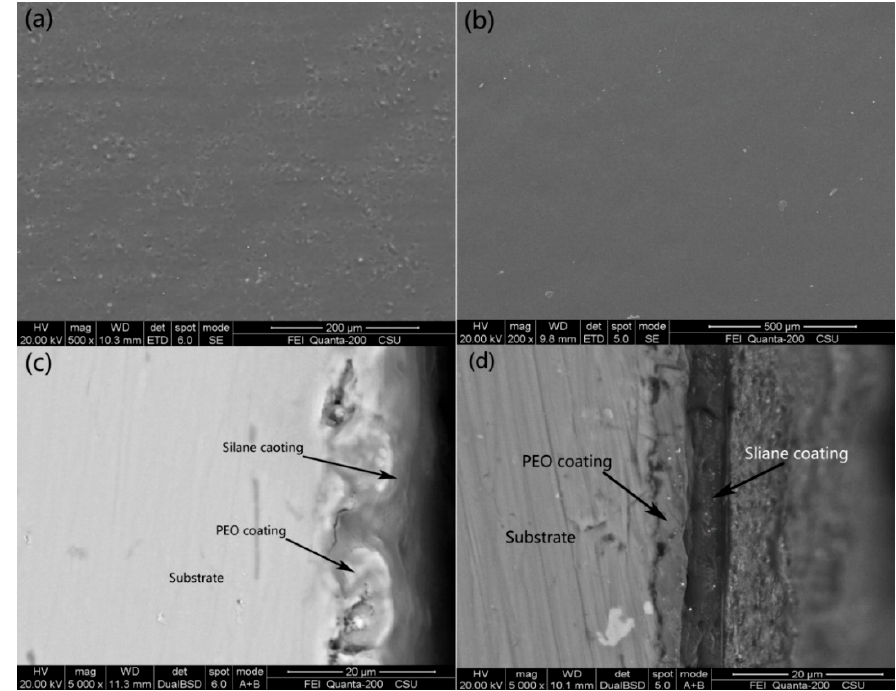
Figure 3. SEM morphology of silane sealed PEO coating: Surface ( a ) and cross-section ( c ) morphology of PEO-S1; Surface ( b ) and cross-section ( d ) of PEO-S2.